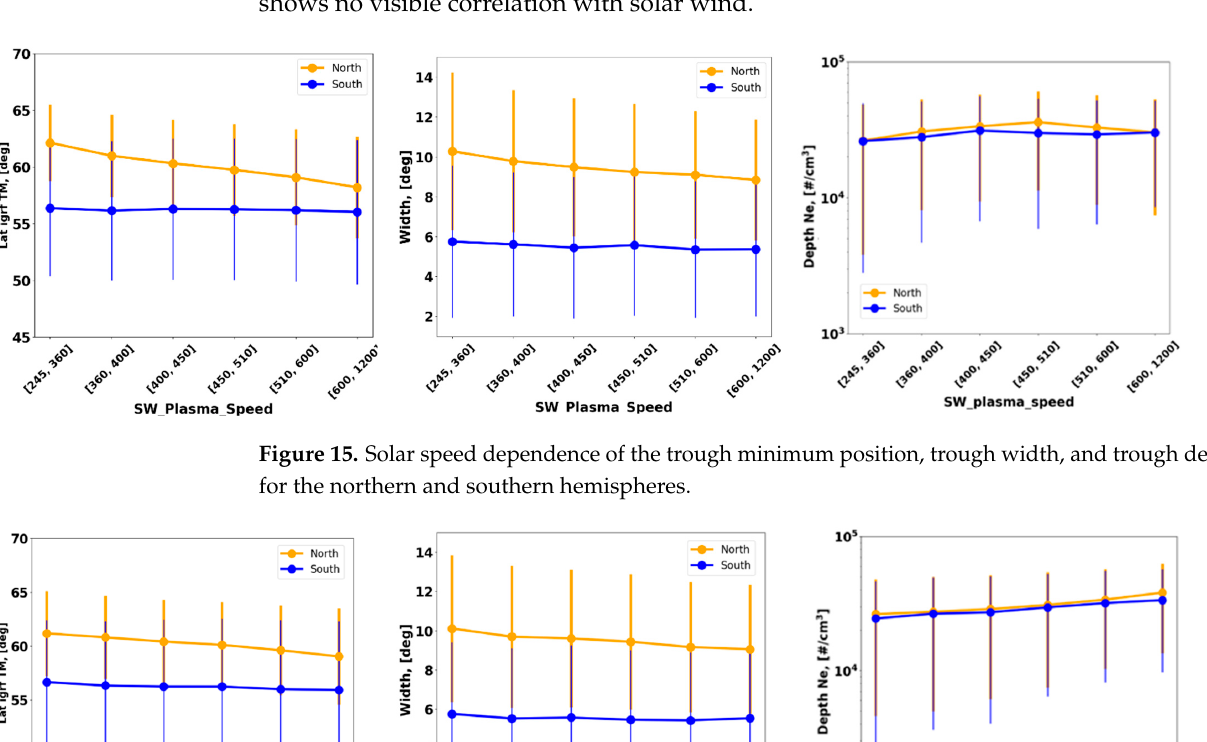
Figure 14. Diurnal variation in trough width and depth for the northern and southern hemispheres as a function of the magnetic local time.